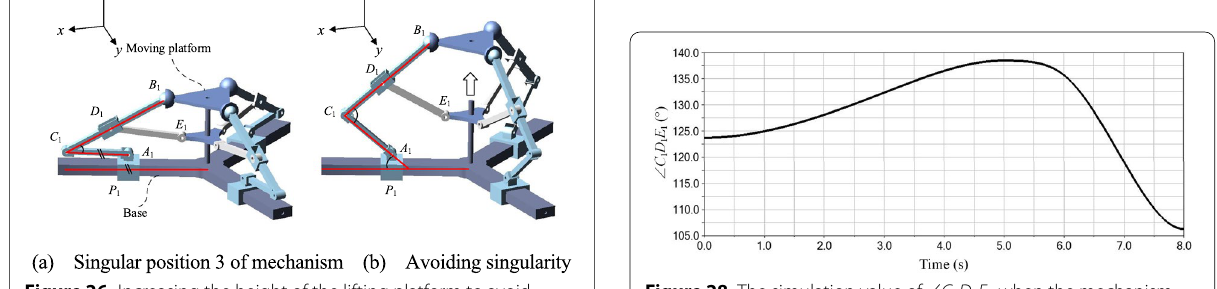
Figure 26 Increasing the height of the lifting platform to avoid singularity at the singular position 3